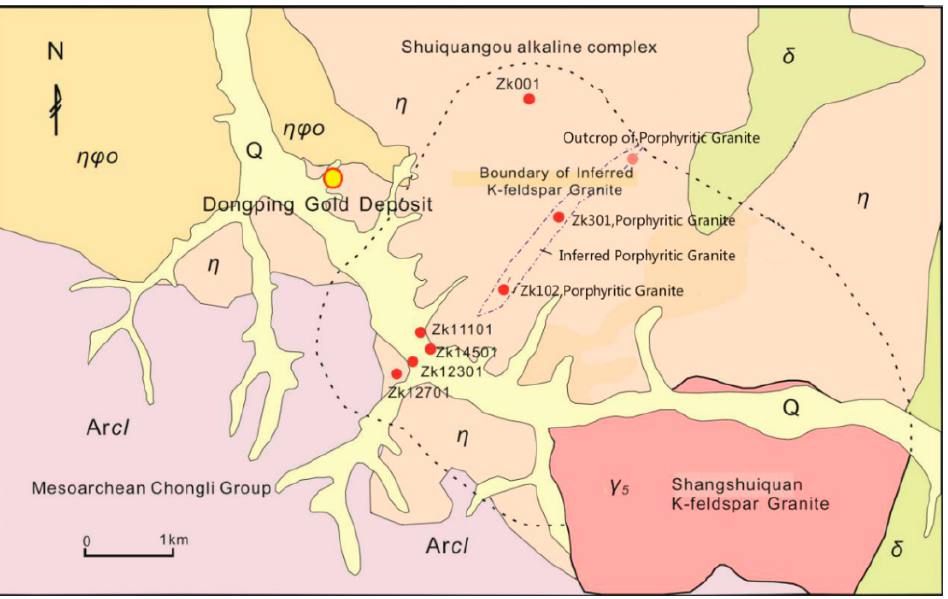
Figure 2. Sketch map of the Dongping gold deposit (after 1:10,000 geological map surveyed by Geological Exploration Report of Dongping Deposit, Chongli Zijin Mining Co., Ltd., Zhangjiakou, China, 2012). Ar cl , Archean Chongli group metamorphic rocks; η , Shuiquangou alkaline complex; ηϕ o, hornblende monzonite; γ 5 , Shangshuiquan K-feldspar granite; δ ,